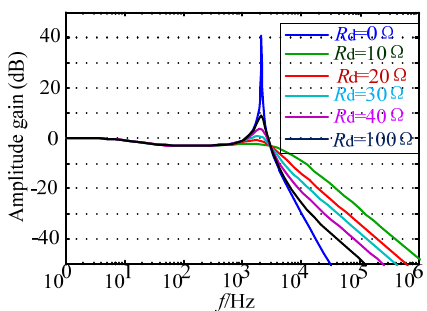
Figure 4. Bode diagram of conventional solution.